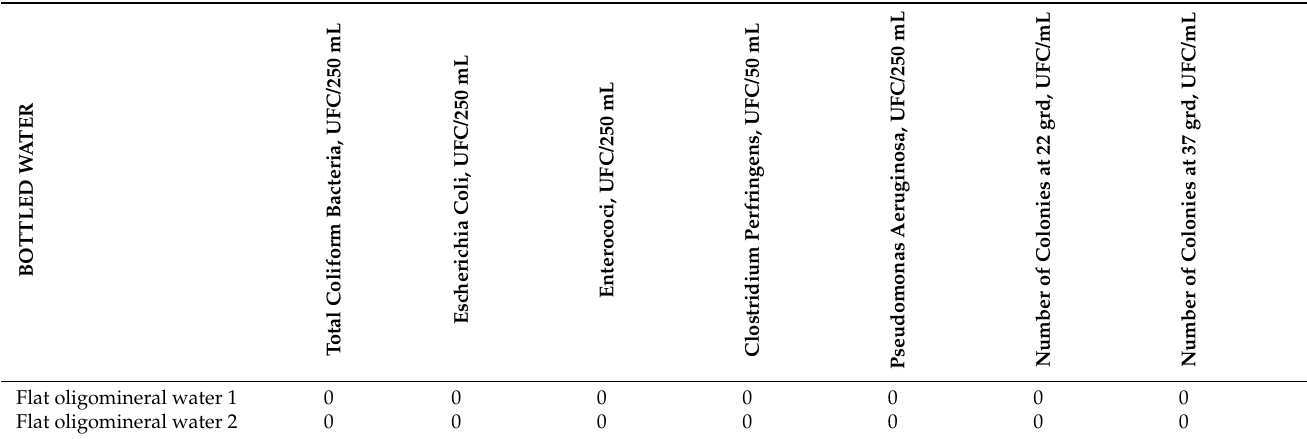
Table 5. Physico-chemical parameters for bottled